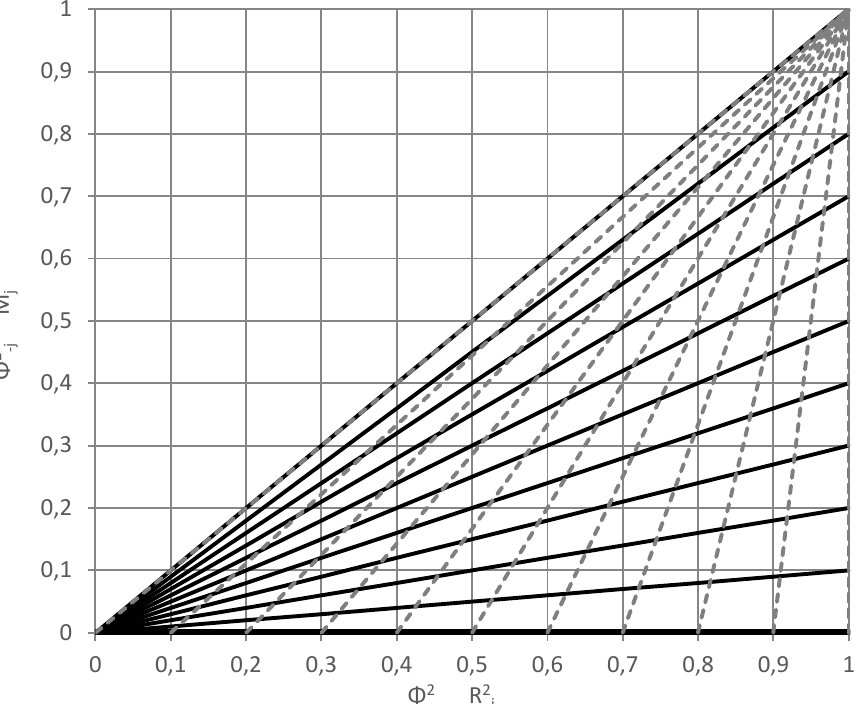
Source: Mihola and Bílková